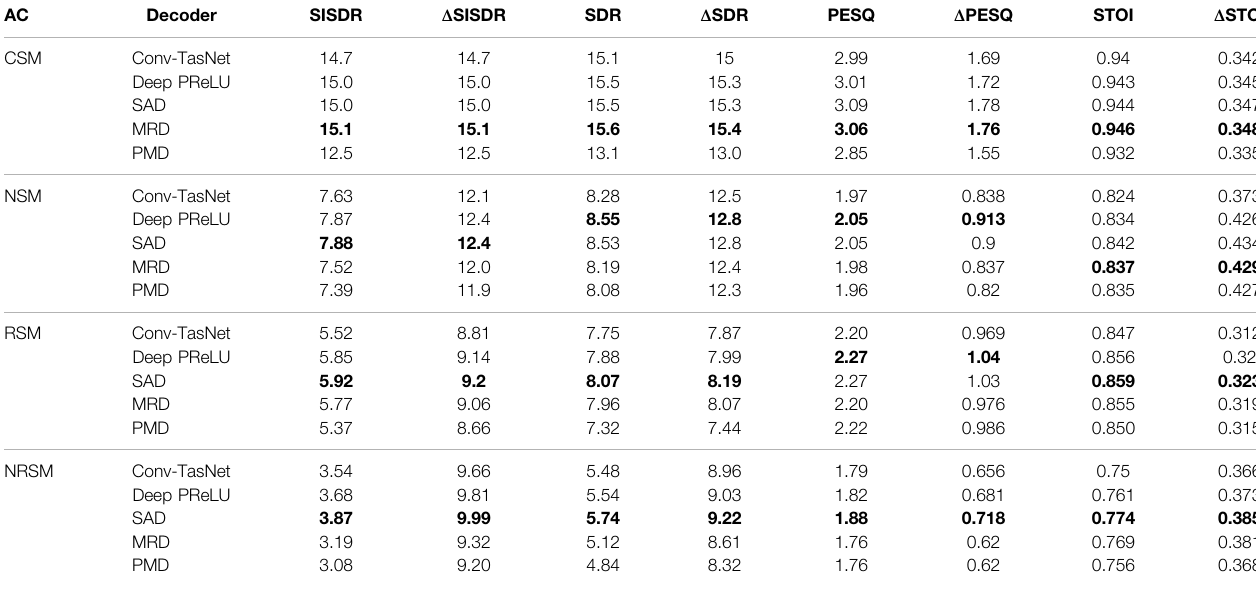
TABLE 4 | Comparison of MRD in Figure 7 (a) to PMD in Figure 7 (b) across various acoustic conditions. Bold indicates the best performing model for each acoustic condition and metric.